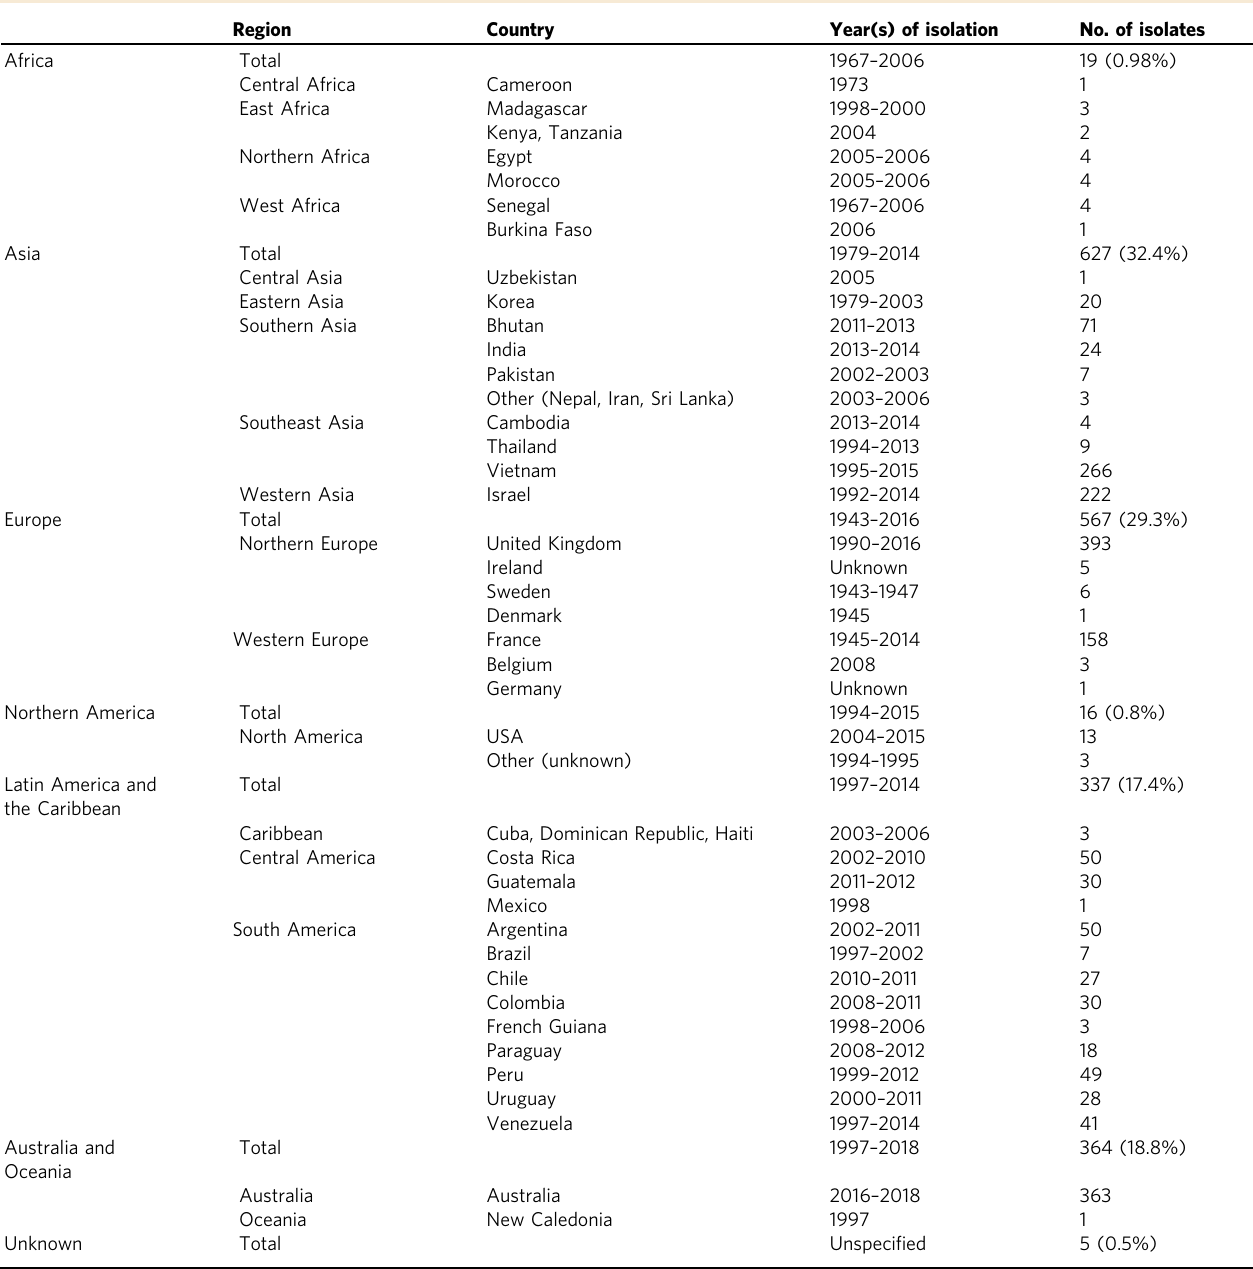
Table 1 Geotemporal distribution of 1935 S. sonnei genomes in the discovery